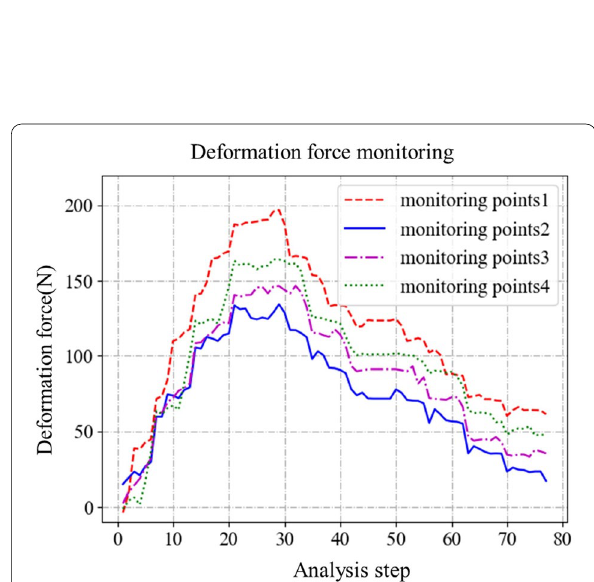
Figure 12 Deformation force curve of the four monitoring points